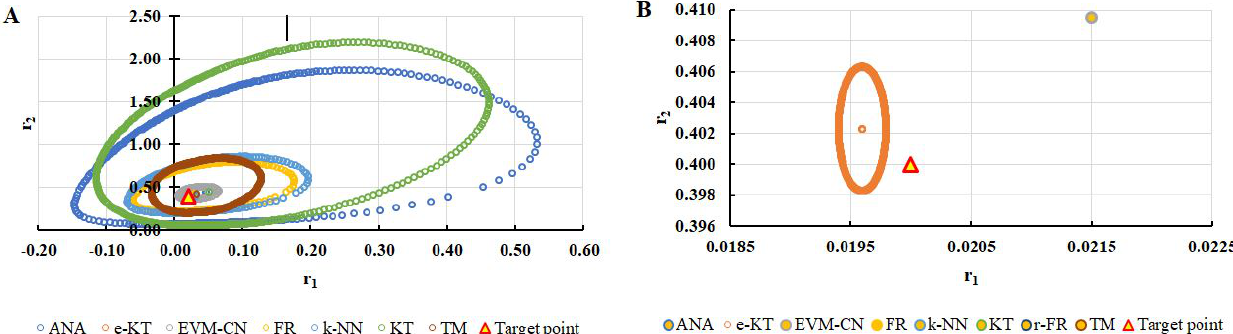
Figure 12. The JCR of analyzed methods for reactivity ratios calculation for LC3 imposed condition ( A ) and detail of smallest JCR with distribution of reactivity ratios ( B ).